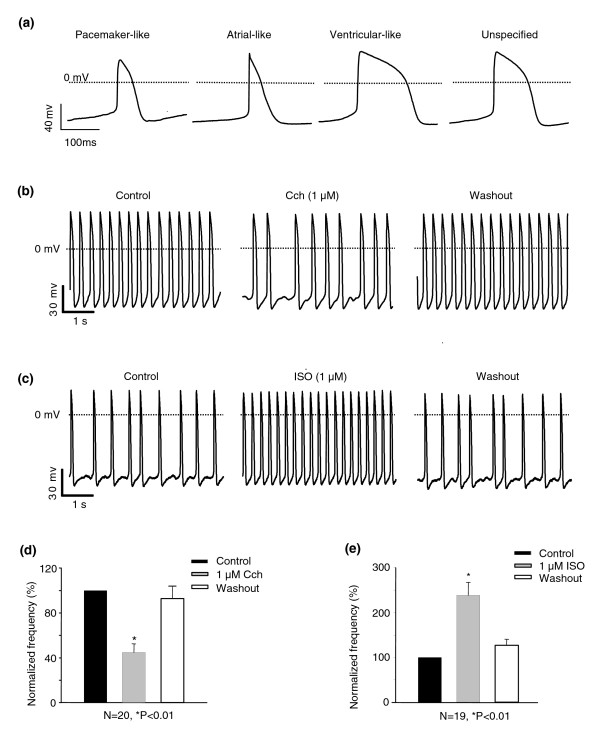
Electrophysiological characterisation of α-MHC+ cells. (a) Characteristic cardiac action potential (APs) of puromycin purified α-myosin heavy chain (MHC)+ cells. Most APs had a typical cardiac AP morphology but could not be further specified. Only few APs exhibited typical features of pacemaker-like, atrial-like, or ventricular-like APs. The minimal diastolic potential was -60.2 ± 1.1 mV. The maximal upstroke velocity was 22.9 ± 2.2 V/s. APD90, APD50 and APD20 (AP duration from maximum to 90%, 50% and 20% repolarization) were 96.4 ± 4.2 ms, 71.1 ± 3.9 ms, and 41.3 ± 2.6 ms, respectively. Representative recordings showing the effect of (b) carbachol (1 μmol/l) and (c) isoproterenol (1 μmol/l) on the spontaneous AP frequency. Statistical analysis of the effects of (d) carbachol (1 μmol/l) and (e) isoproterenol (1 μmol/l) on the spontaneous AP frequency. Carbachol caused a decrease whereas isoproterenol increased the spontaneous AP frequency.